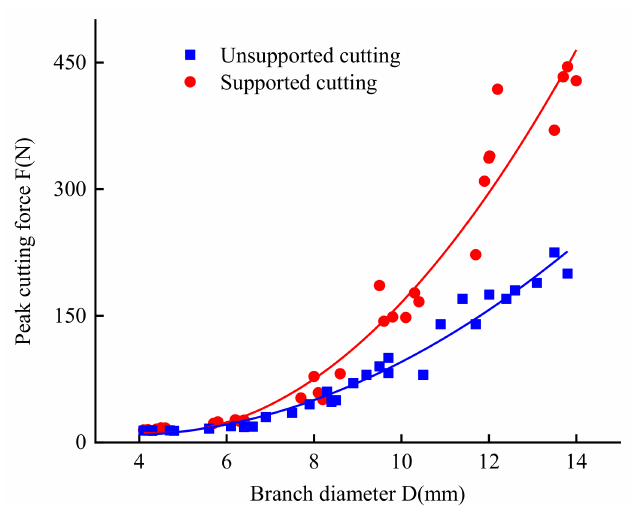
Figure 5. Relationship between the C.k. branch diameter and peak cutting force. Note: average cutting speed is 3.36 m · s − 1 ; wedge angle is 25 ◦ ; slip cutting angle is 20 ◦ ; cutting gap is 1 mm; cutting height is 5 cm; moisture content is